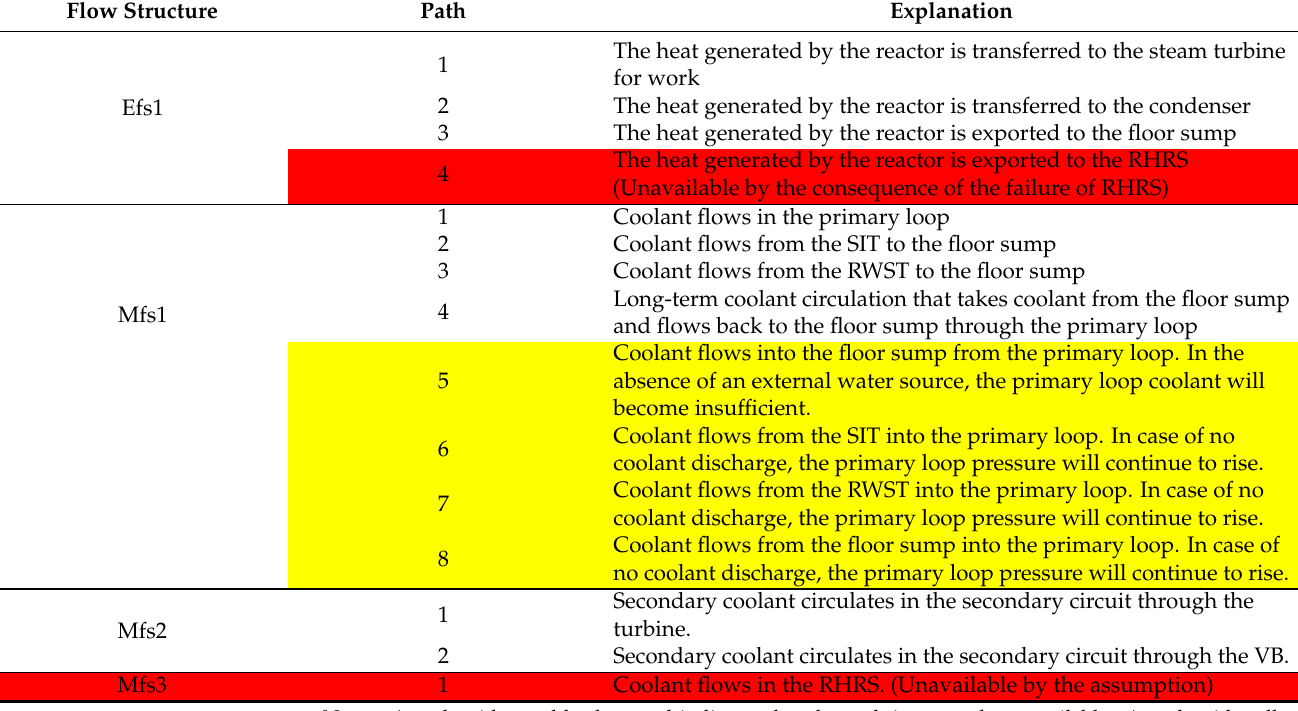
Table 4. Success paths identi fi ed after removing the paths with obvious hazard consequences.